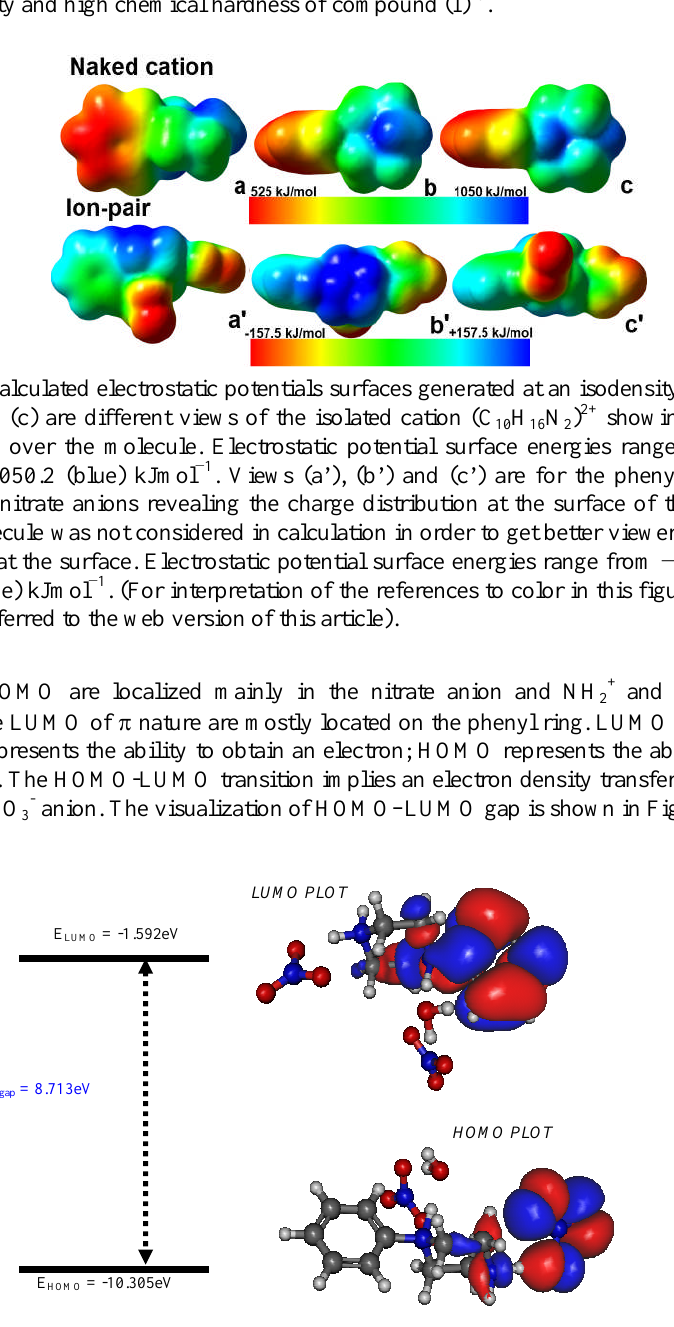
Figure 4. Molecular orbital surfaces and energy level for the HOMO, LUMO and the energy gap of (I) computed by PM6-DH2